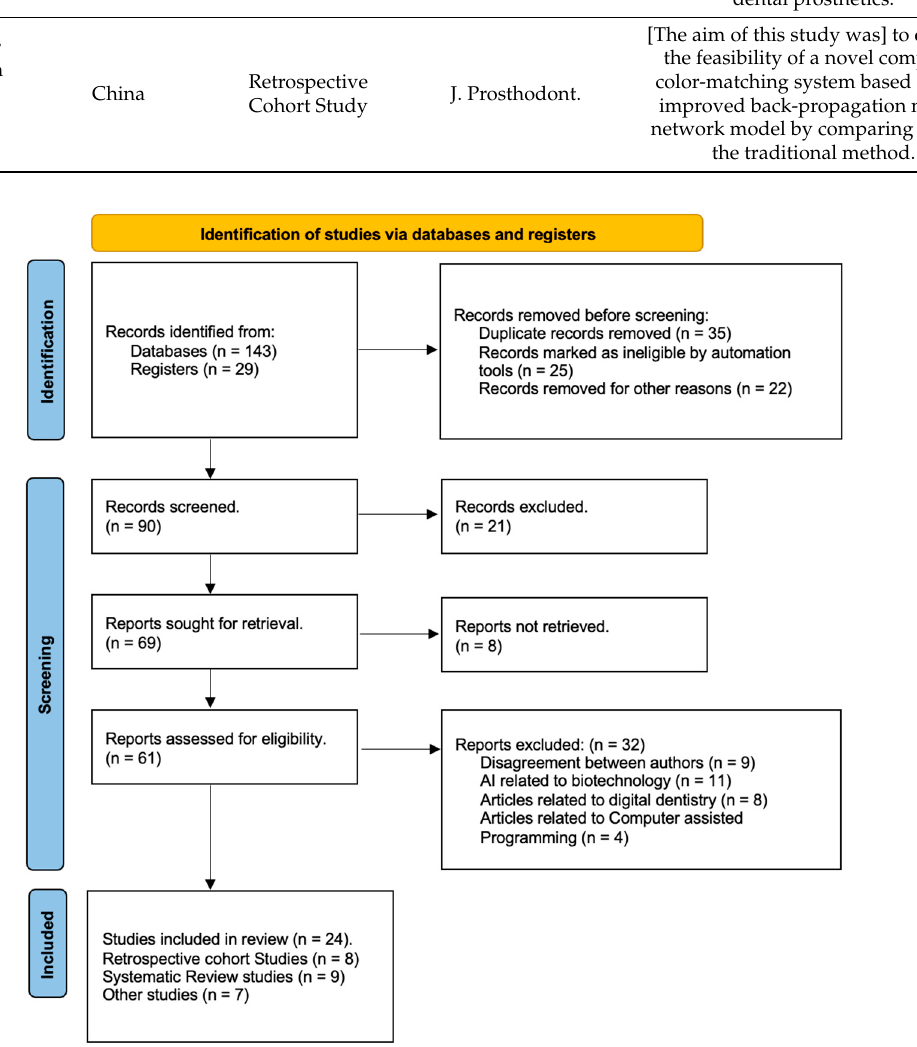
Figure 2. Flowchart of the Prisma.